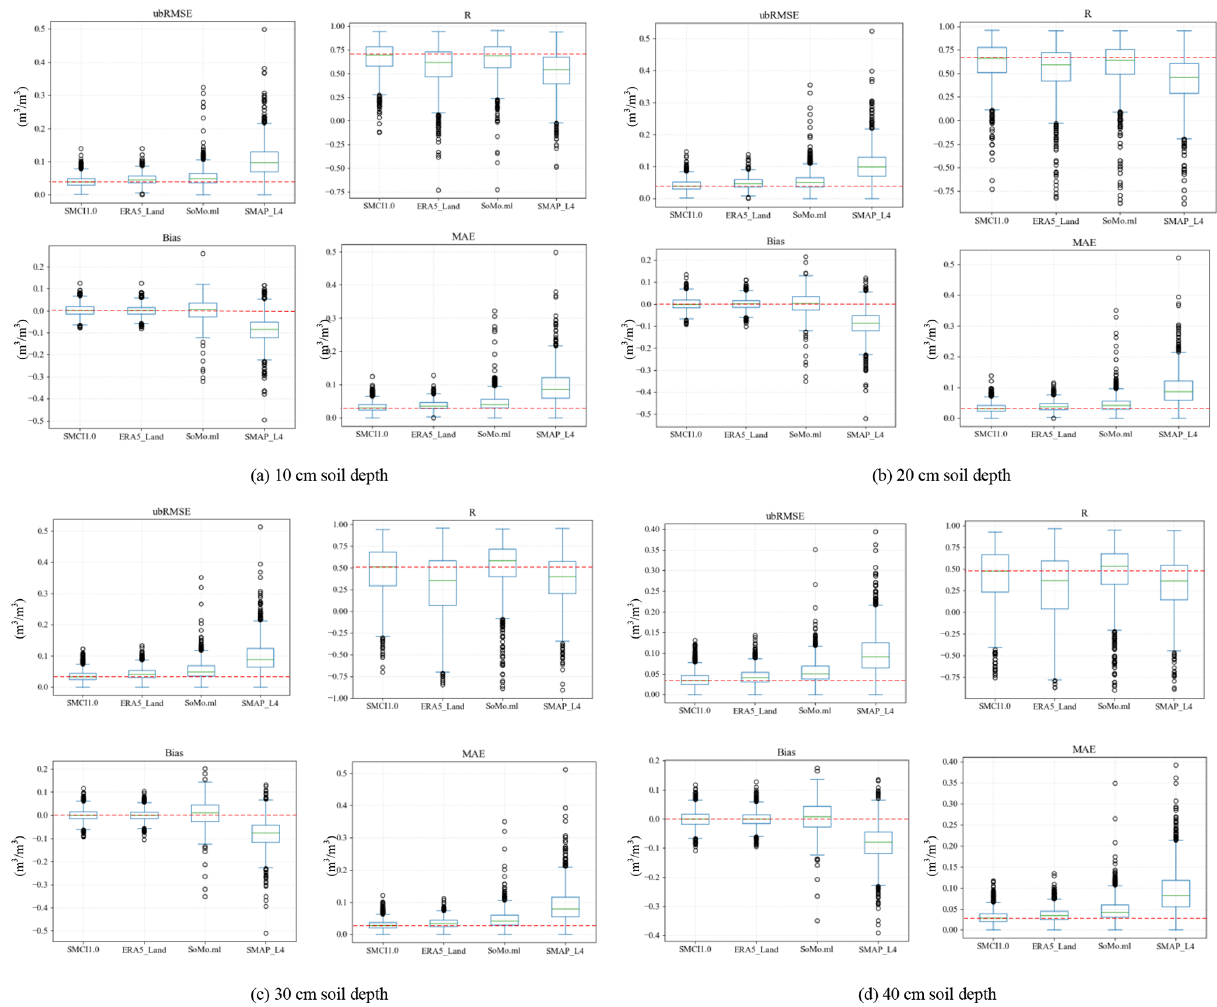
Figure 4. Comparison between gridded datasets (SMCI1.0, ERA5-Land, SoMo.ml, and SMAP_L4) at soil depths of (a) 10cm, (b) 20cm, (c) 30cm, and (d) 40cm. The red lines indicate the zero value for bias and the best performance among datasets for ubRMSE, R , and